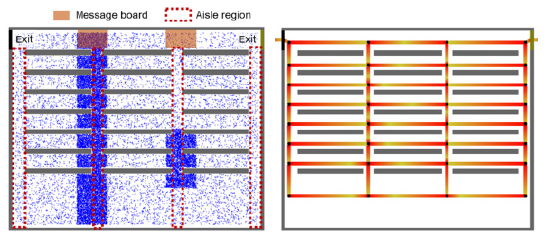
Fig. 22 Two-exit environment. Left: 35,000 agents (blue dots). Right: route computed by our method.